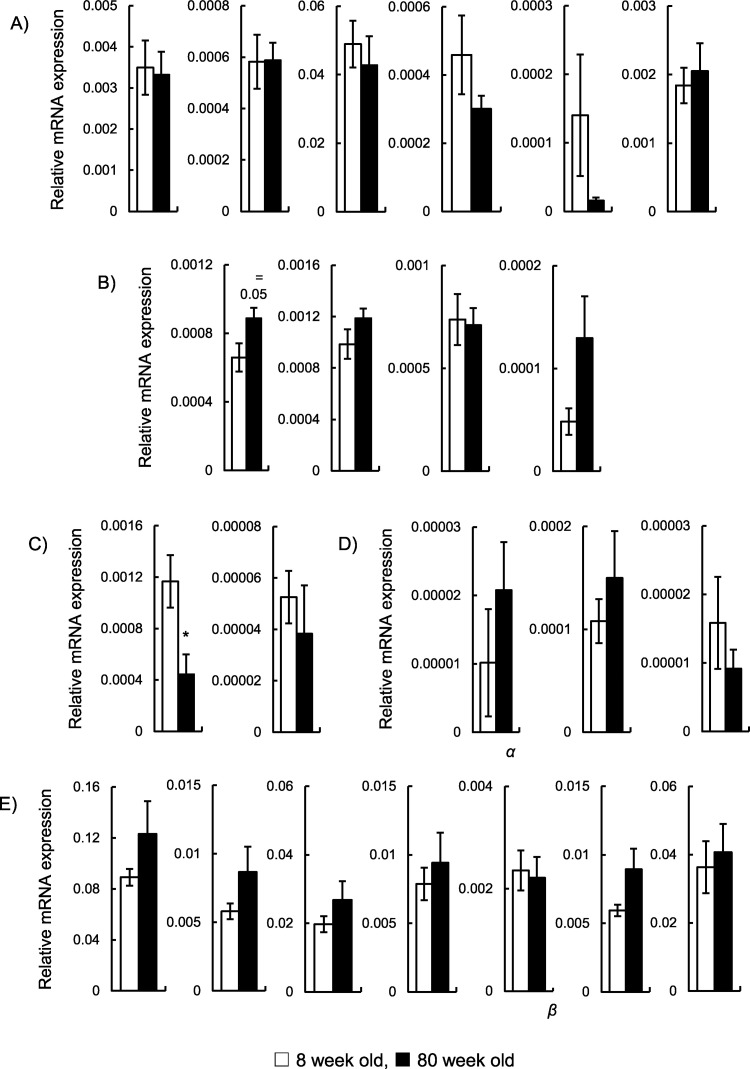
Comparison of mRNA expression in the hippocampus.Quantitative mRNA expression for (A) nerve growth factor, (B) NADPH oxidase, (C) nitric oxide synthase, (D) inflammatory, and (E) long-term memory store-related genes of 8-week-old (white column, n = 6) and 80-week-old mice (gray column, n = 6). * p > 0.05 (Welch’s t-test).